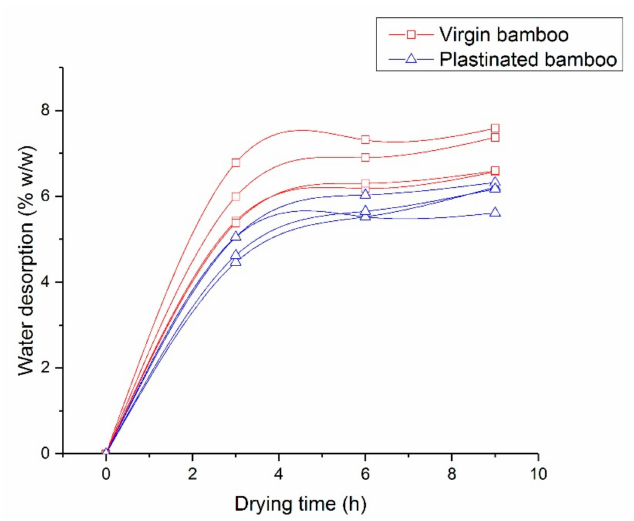
Figure 5. Moisture desorption curves for virgin and plastinated bamboo. Notice the lower residual moisture in plastinated bamboo with reduced moisture di ff usivity constant as compared to virgin bamboo.